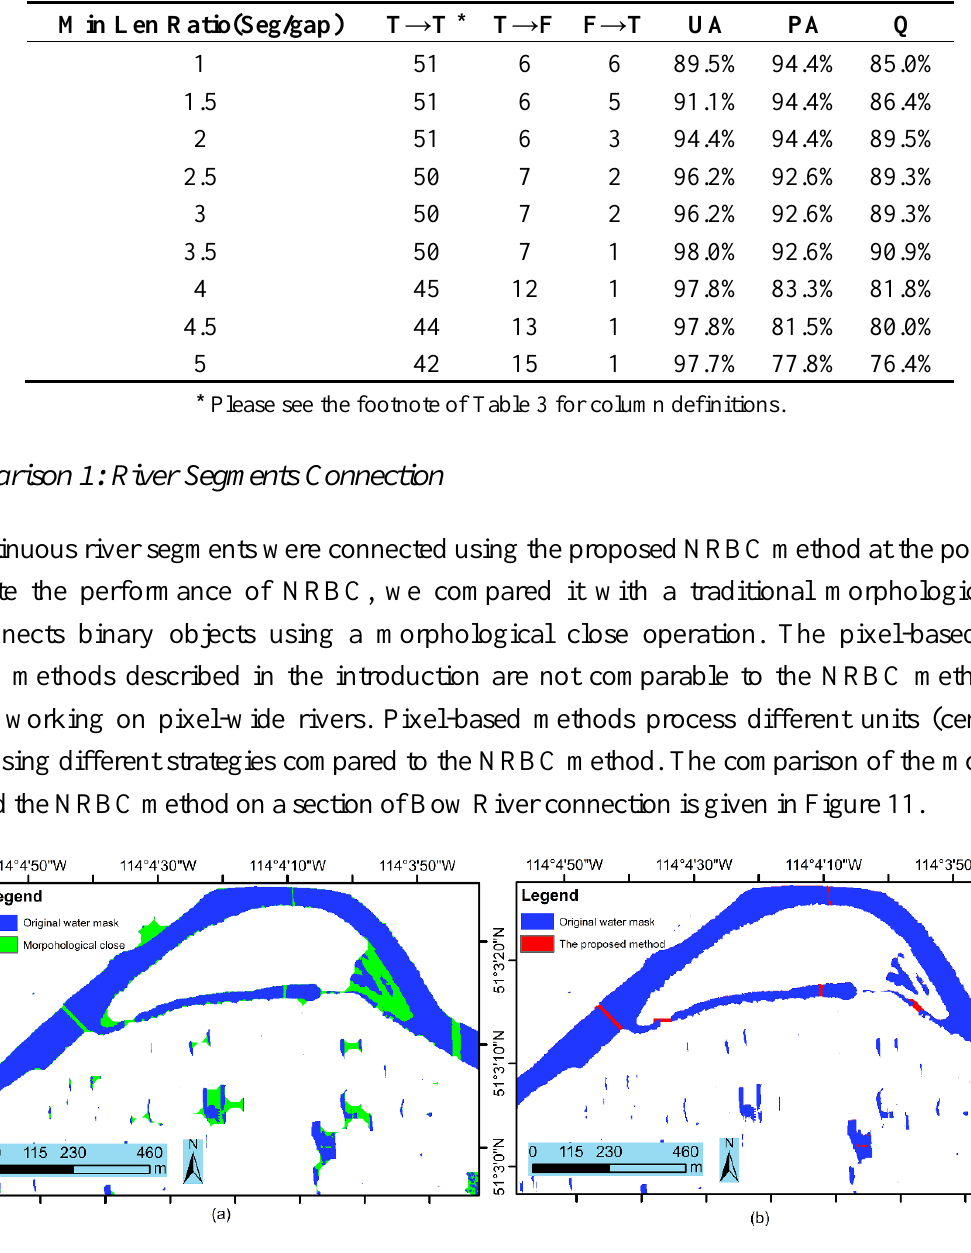
Figure 11. The comparison of river connection using ( a ) the morphologic algorithm and ( b ) the NRBC method. The morphometric method mistakenly connects shadows and noise segments The NRBC method selectively connects only meaningful river segments based on its